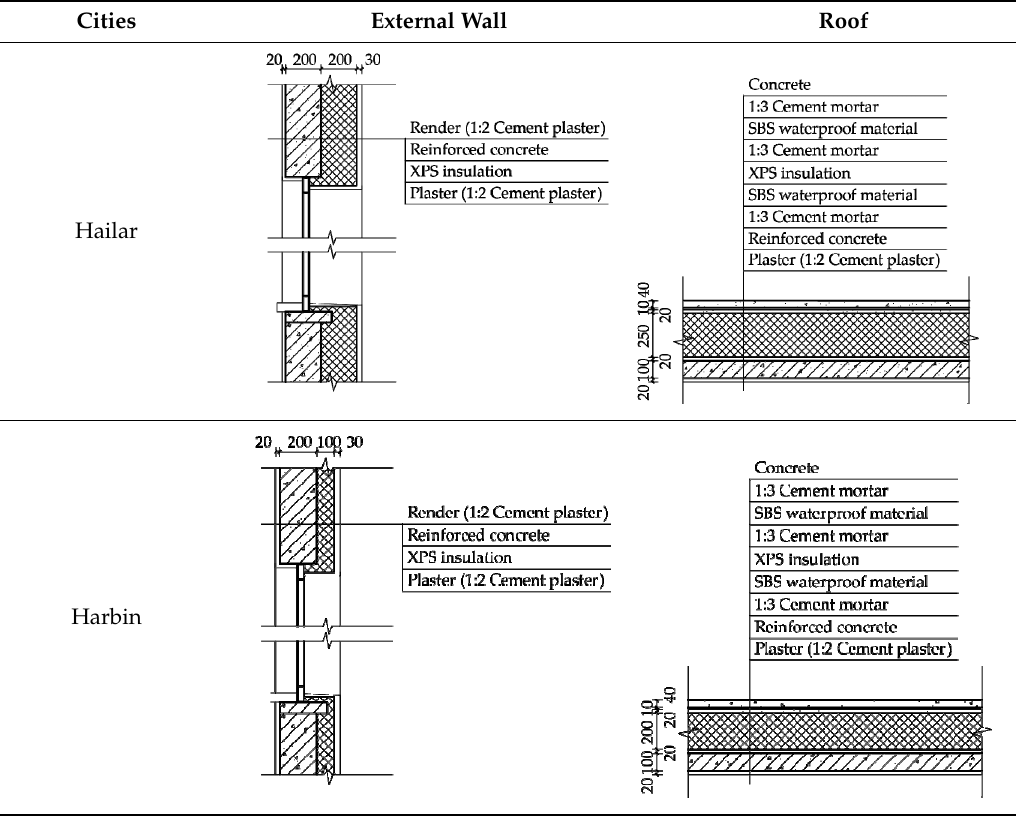
Figure 5. Details of the architectural design. ( a ) Standard floor plan of the residential case study building. ( b ) 1-1 and 2-2 sections of the building. Table 5. External wall and roof designs for the RC residential buildings in the six cities.